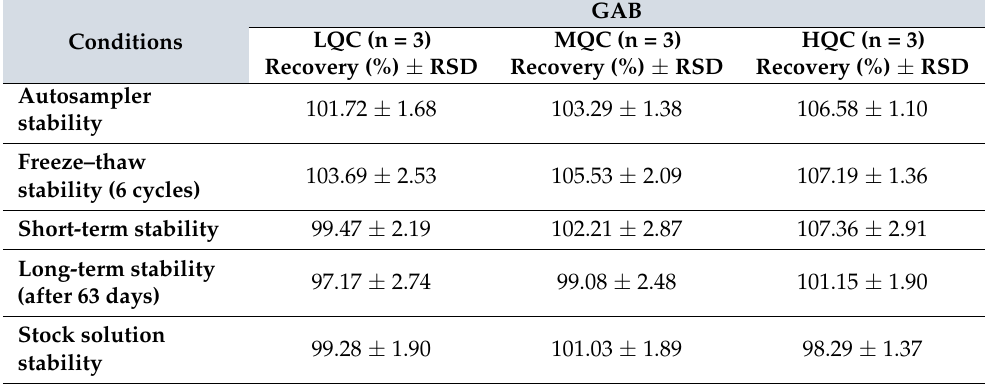
Table 5. Outcomes of stability study under diverse environments for the assay of GAB QC specimens in human plasma, using the new method.